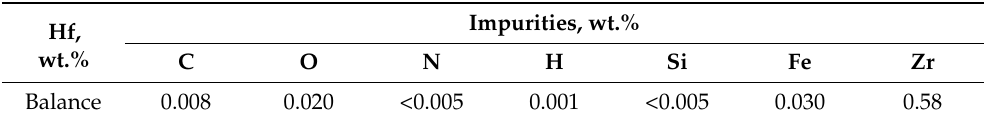
Table 2. Chemical composition of the hafnium wire with a diameter of 2 mm, used as a charge material for melting of TiNiHf initial ingots.